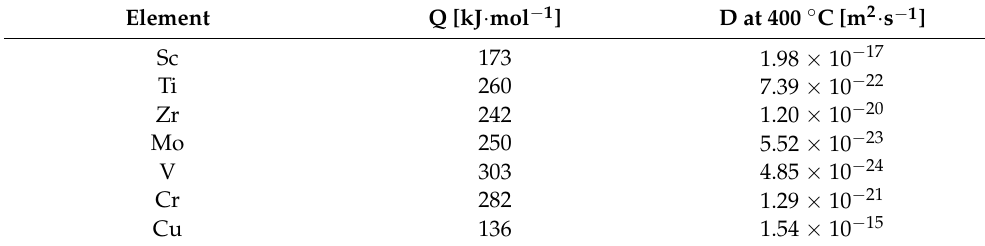
Table 1. Diffusivity and activation energy values of selected transition metals